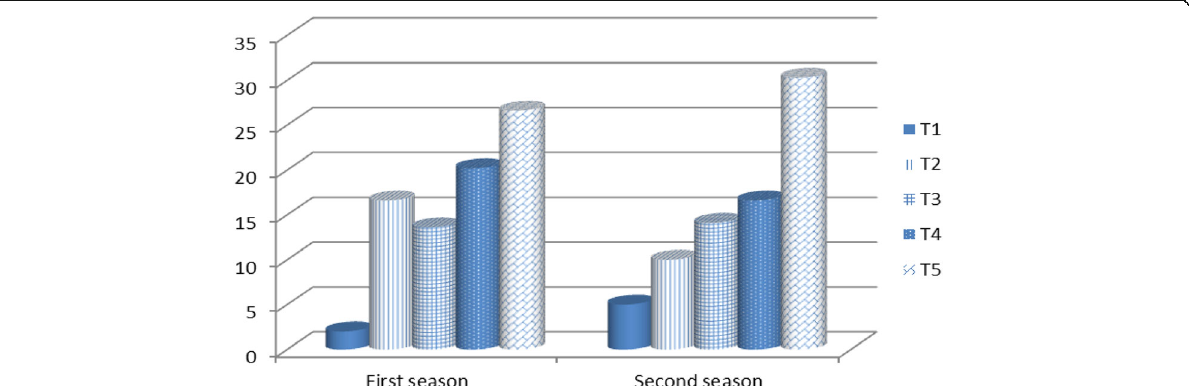
Fig. 1 Effect of preharvest spraying with moringa leaf extract, boric acid, and chelated calcium on decay percentage after 8 weeks of Hollywood plum fruits stored at 0 ± 1 °C and RH 85 – 90% during 2018 and 2019 seasons